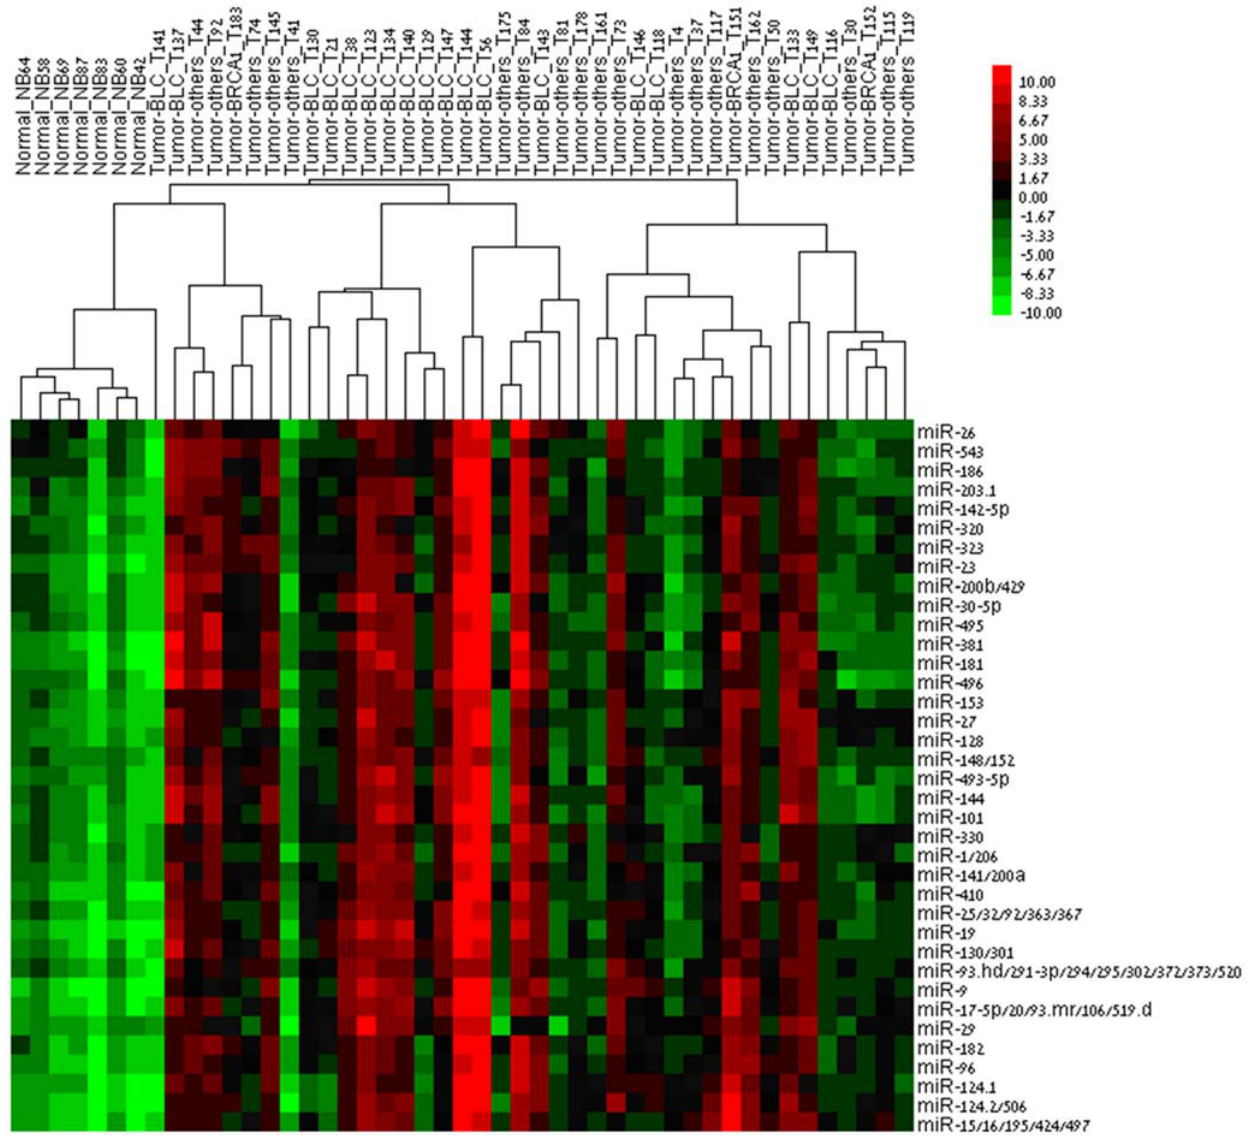
Figure 2. Hierarchical clustering of breast samples by MiR-seed activity scores. Clustering was done by complete linkage on cluster 3.0 according to the correlation (centered) similarity metric, after selecting miR-seeds for which the SD is at least 4. It can be observed that normal samples are clustered together. Most of the BLC tumor samples are also grouped together. Prior to clustering, samples were randomly shuffled. Color code: red means increased activity of miR-seeds; green decreased (Spearman rank correlation, complete